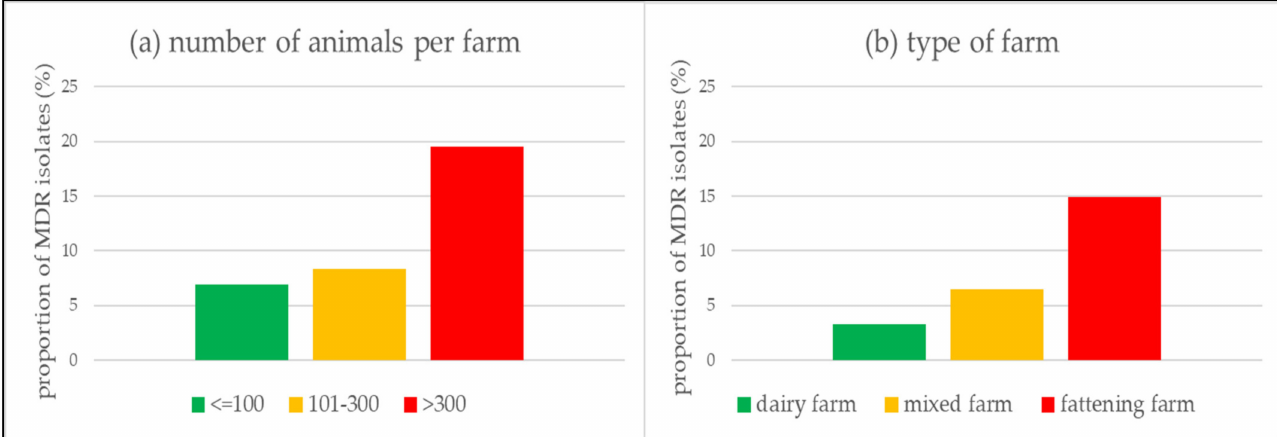
Figure 4. Proportion of multidrug-resistant (MDR) P. multocida and M. haemolytica isolates depending on farm size (number of animals per farm) ( a ) and type of farm ( b ). In farms with more than 300 animals, the odds for isolating MDR isolates were significantly higher than in farms with 100 or less animals (Adjusted OR = 2.89; 95% CI: 1.26–7.29; p = 0.017). In addition, the odds for isolating MDR isolates were significantly lower in dairy (aOR = 0.23; 95% CI: 0.08–0.54; p = 0.002) and mixed farms (aOR = 0.46; 95% CI: 0.20–0.93; p = 0.042) than in fattening